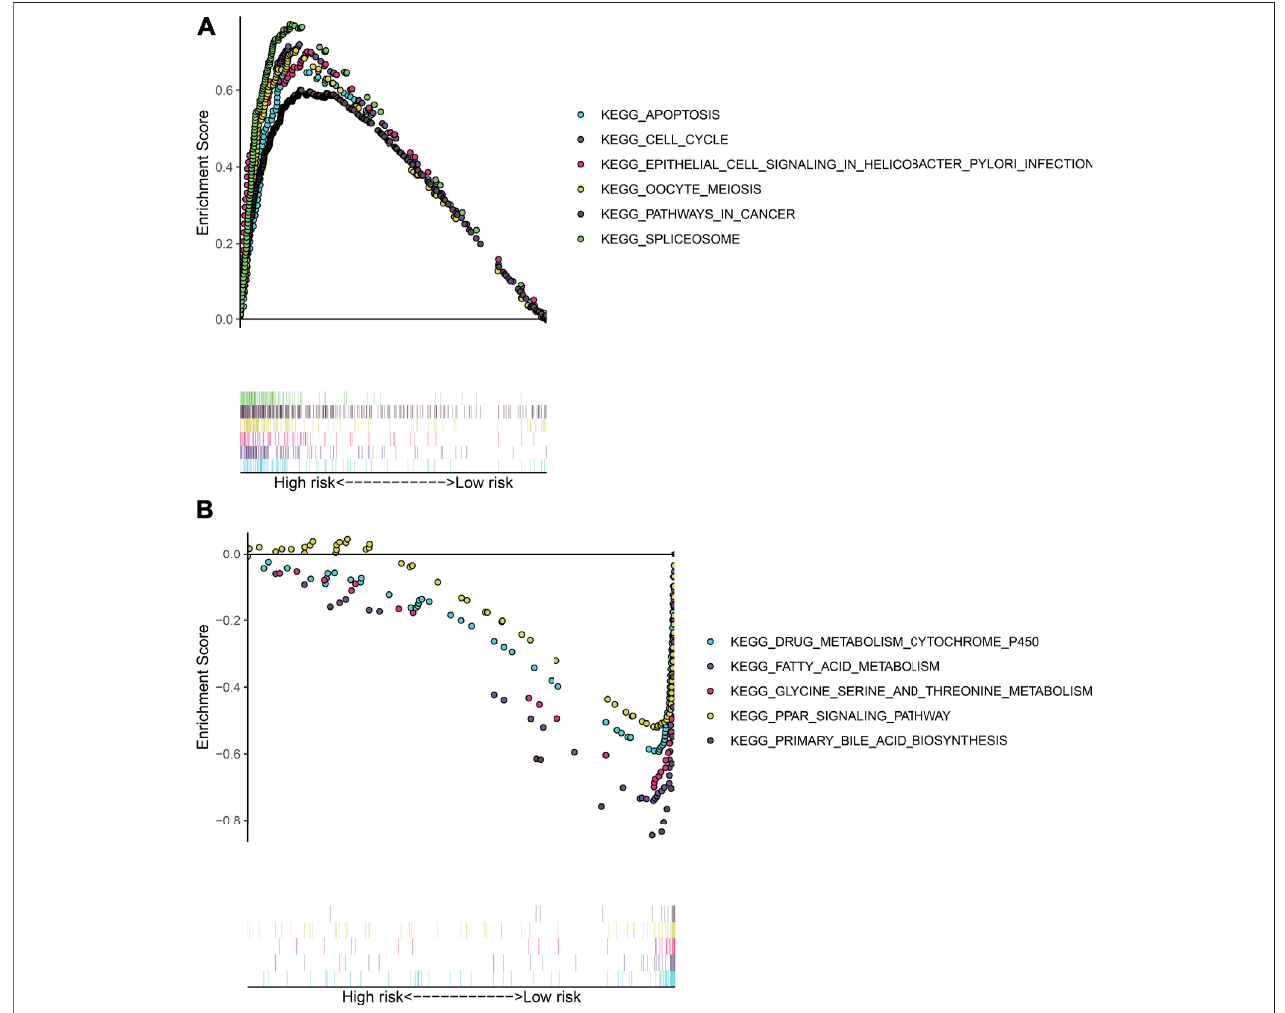
FIGURE 4 | Signaling pathways involving the TLR signature through GSEA. (A) KEGG pathways that were activated in HCC subjects with high TLR-based RS: apoptosis, cell cycle, epithelial cell signaling in Helicobacter pylori infection, oocyte meiosis, pathway in cancer, and spliceosome. (B) KEGG pathways that were activated in HCC subjects with low TLR-based RS: metabolism cytochrome P450, fatty acid metabolism, glycine serine and threonine metabolism, PPAR signaling pathway, and primary bile acid biosynthesis.